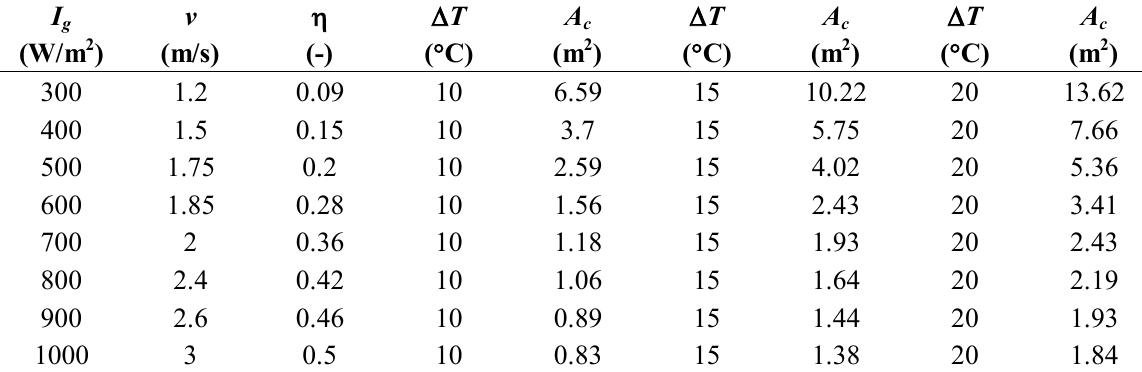
Table 1. Area of solar air collector for three gradient of temperature, for a family